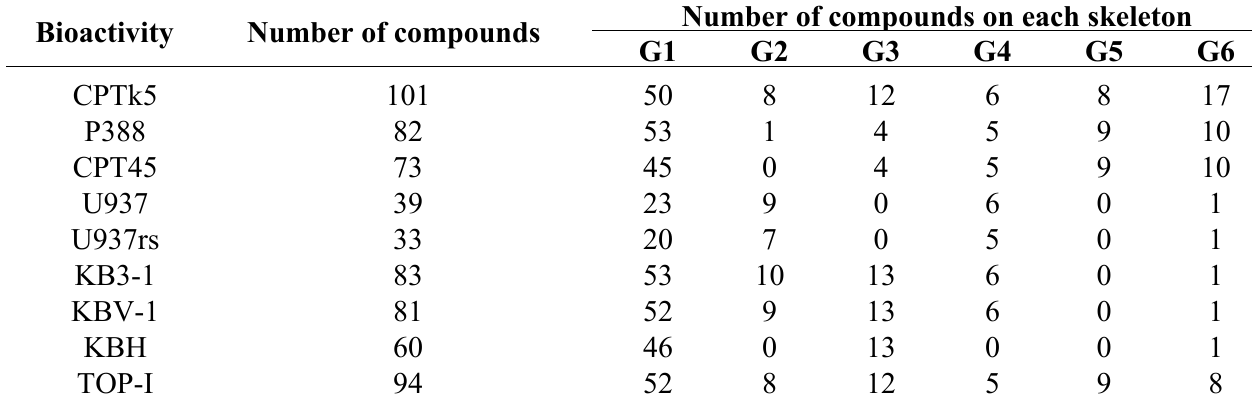
Table 1. Dataset and biological activities used in this study.